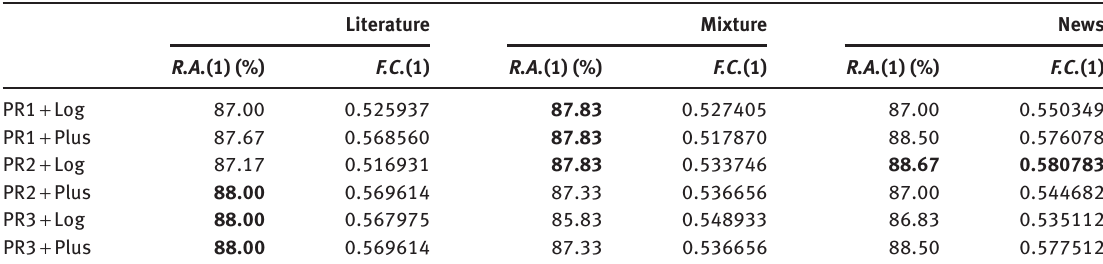
Table 4: Results of Modified